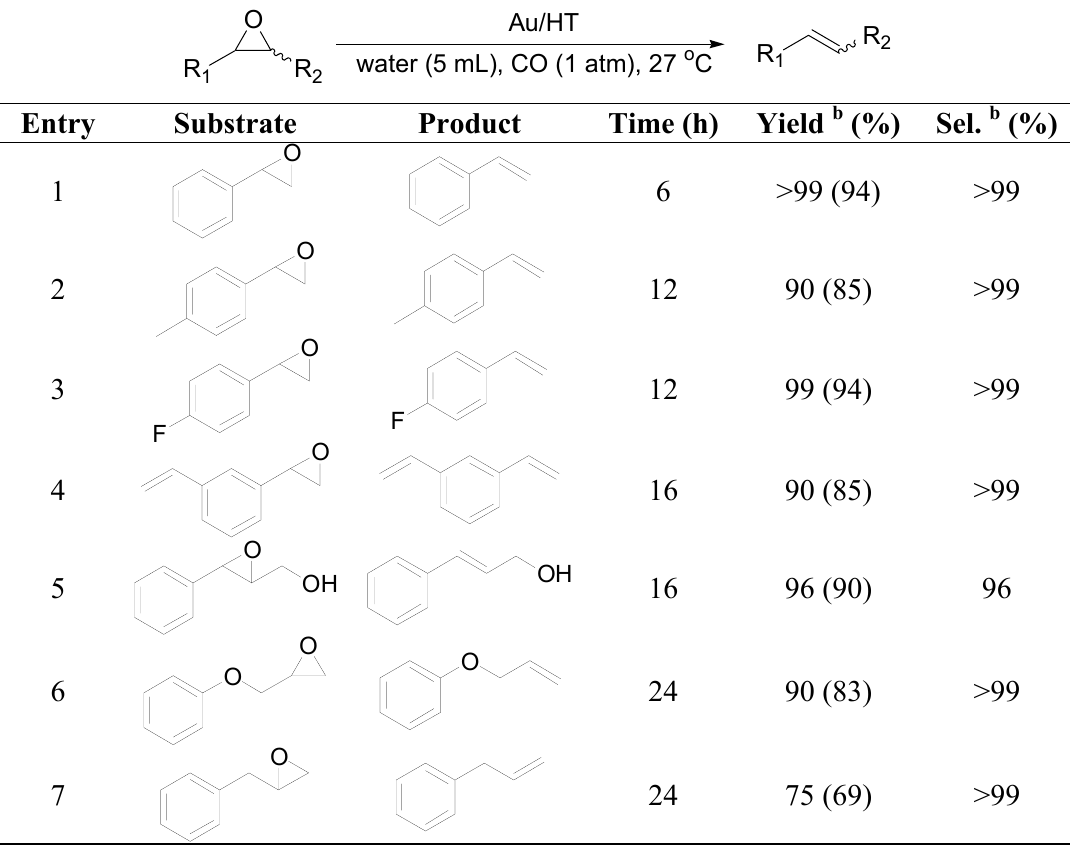
Table 4. Deoxygenation of various epoxides with CO/H